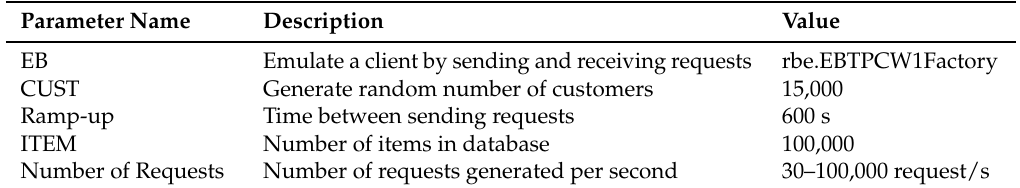
Table 4. Workload configuration parameters.